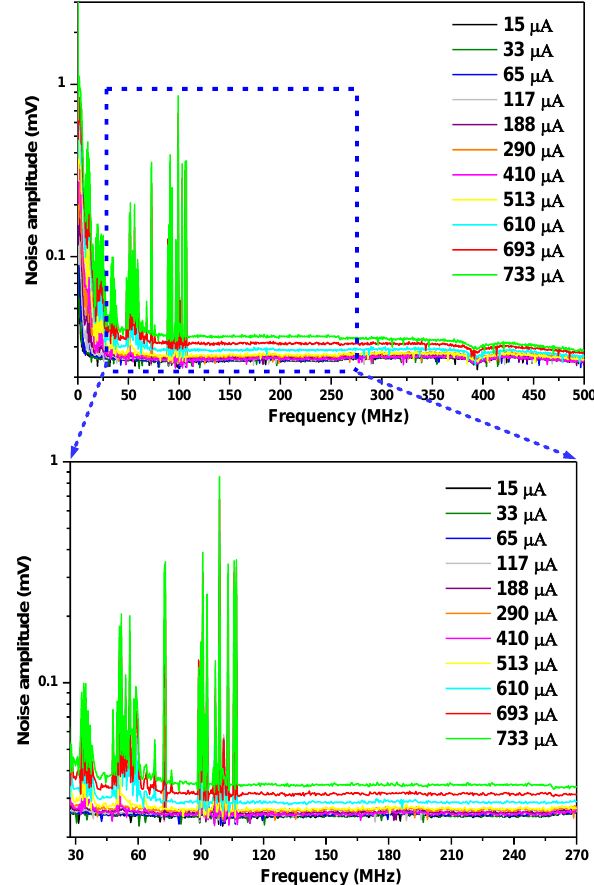
Figure 4. ( upper ) noise density spectra from the RF output of the photomixer at different LO power- induced photocurrents measured with a signal analyzer; ( lower ) zoom of the upper figure in the pass-band of 27.5–270 MHz.